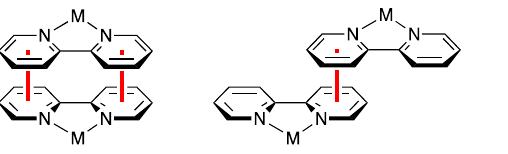
Scheme 1. Hydrogen atom numbering in 2,2 ′ -bipyridine; the conformation adopted by the metal- coordinated chelating ligand is shown.